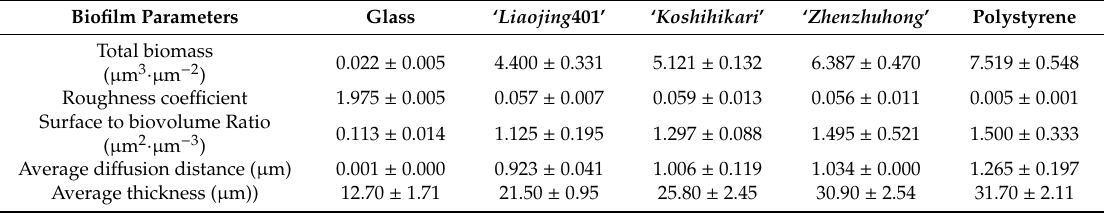
Figure 4. Morphological characterization of biofilm on the di ff erent surfaces of Glass, ‘ Liaojing 401’, ‘ Koshihikari ’, ‘ Zhenzhuhong ’ and polystyrene by SEM ( a1 , b1 , c1 , d1 , e1 ; a2 , b2 , c2 , d2 , e2 ; 2 are enlarged views of 1) and by CLSM ( a3 , b3 , c3 , d3 , e3 ). Table 1. Confocal laser scanning microscopy parameters of JM2-gfp biofilm on the surfaces of glass, ‘ Liaojing 401’, ‘ Koshihikari ’,‘ Zhenzhuhong ’and polystyrene after 48 h of growth. Data are shown as mean ±